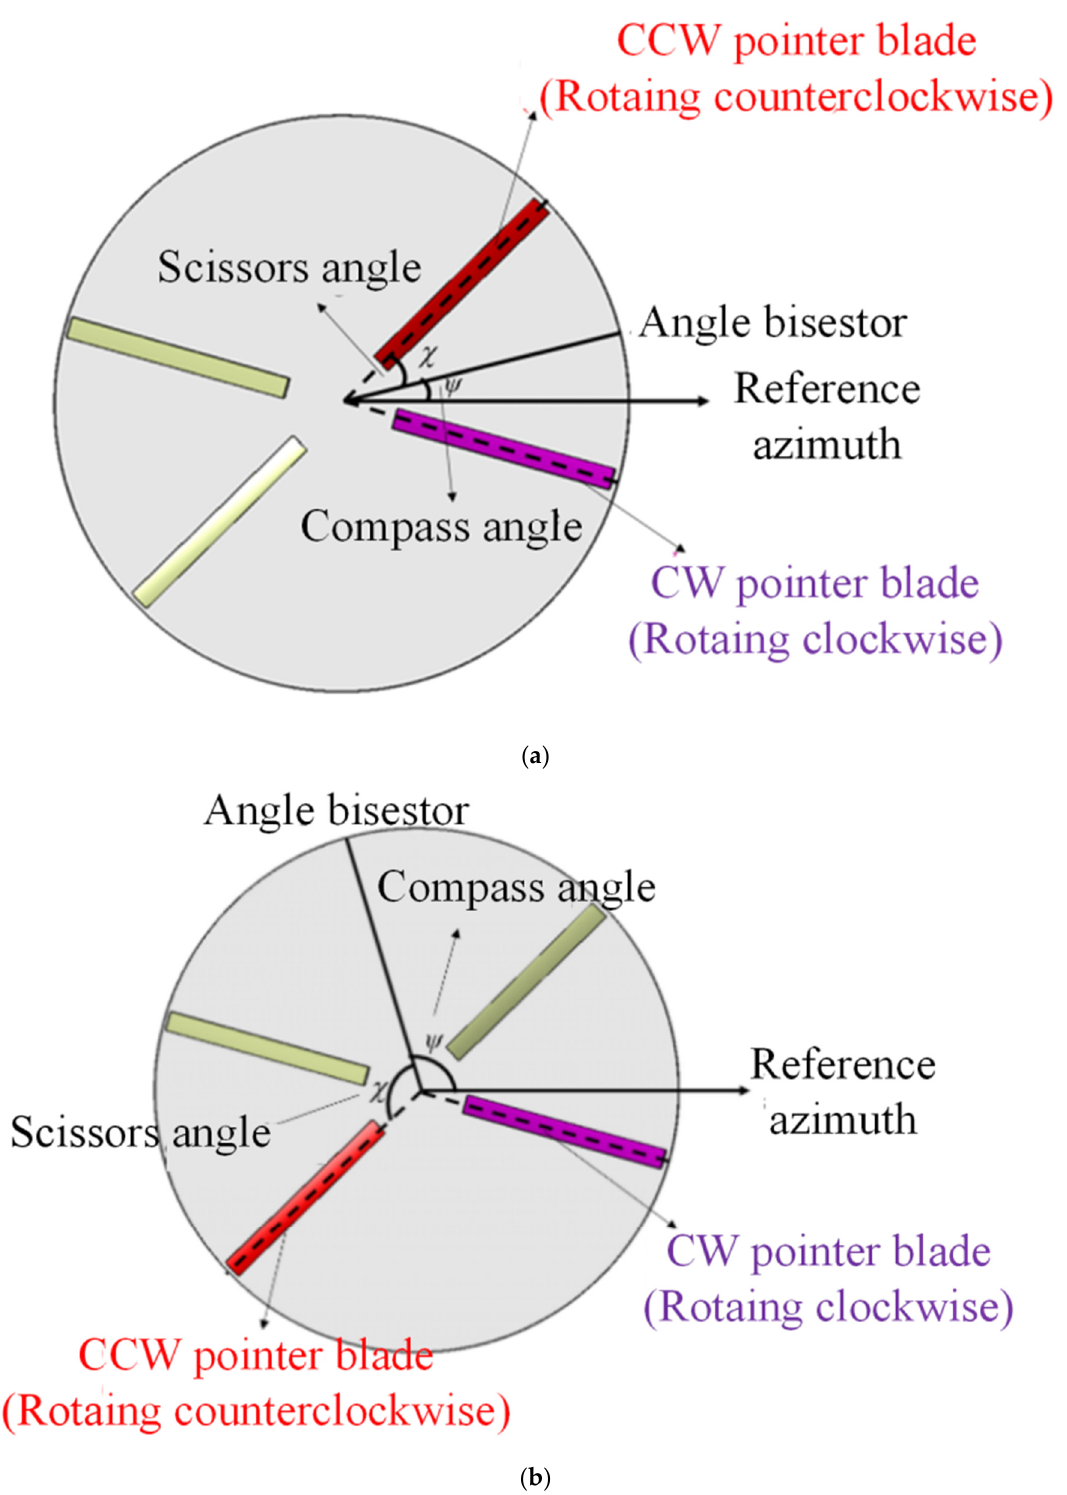
Figure 6. Schematic diagram and model elements of CSM for coaxial rotor: ( a ) Compass angle ≤ 90°, ( b ) Compass angle > 90 ° . ( b ) Compass angle > 90 ◦